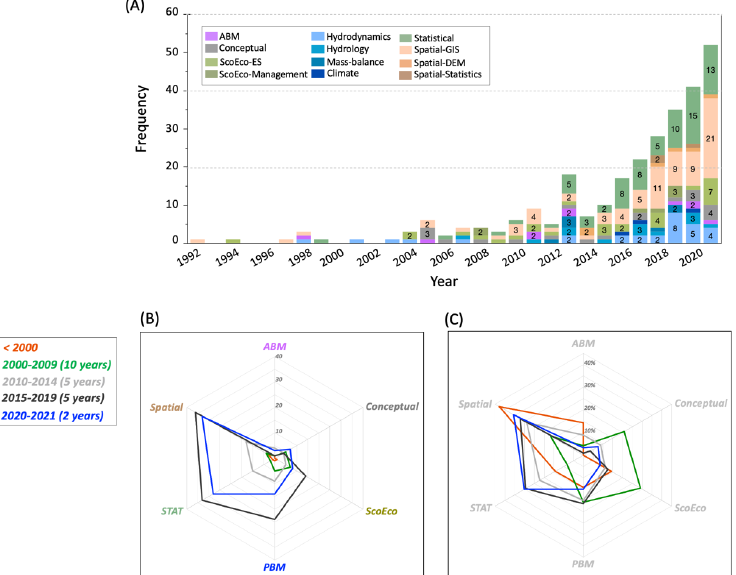
Figure 2. Number of publications (total) on mangrove modeling research explicitly applied to mangrove restoration and rehabilitation projects by 2021. ( A ) Chronological trend of publications for different model types. Radar graphs show the absolute count ( B ) and relative count ( C ) of publications for each model type within different periods (<2000; 2000 – 2009: 10 years; 2010 – 2014: 5 years; 2015 – 2019: 5 years; and 2020 – 2021; 2 years).